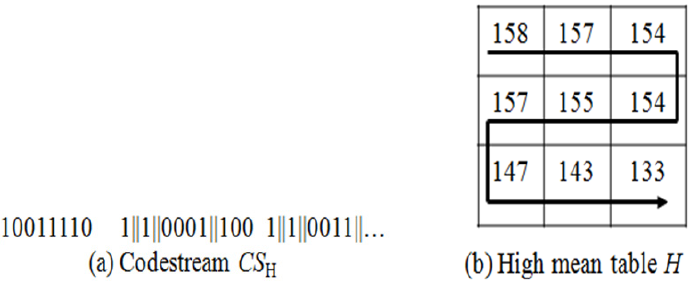
Figure 7. Example of the extracting algorithm for high mean table: ( a ) codestream CS H ; ( b ) high mean table H.